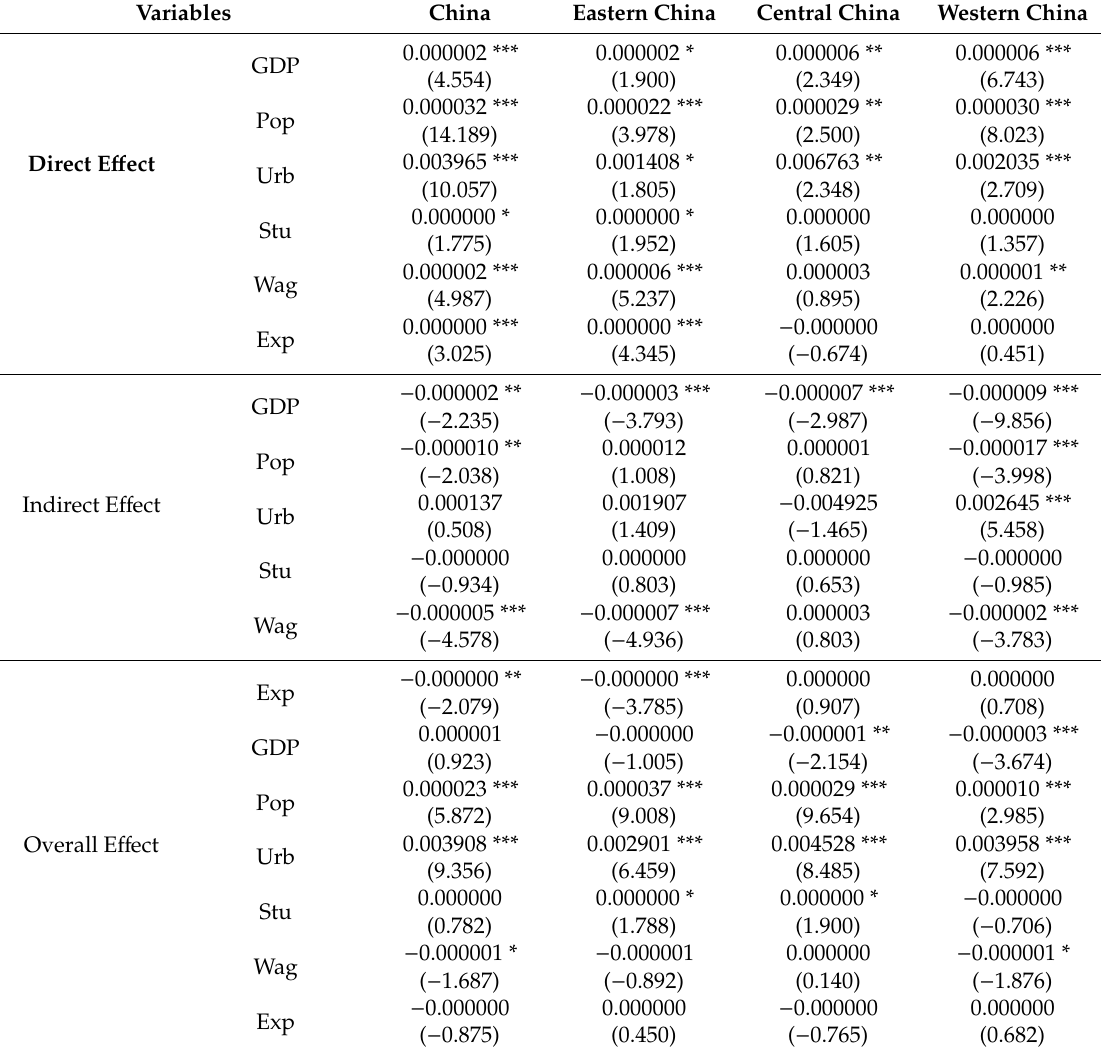
Table 7. Direct, Indirect, and Overall E ff ects of the Model Based on Geographic Distance Weight Matrix. Variables China Eastern China Central